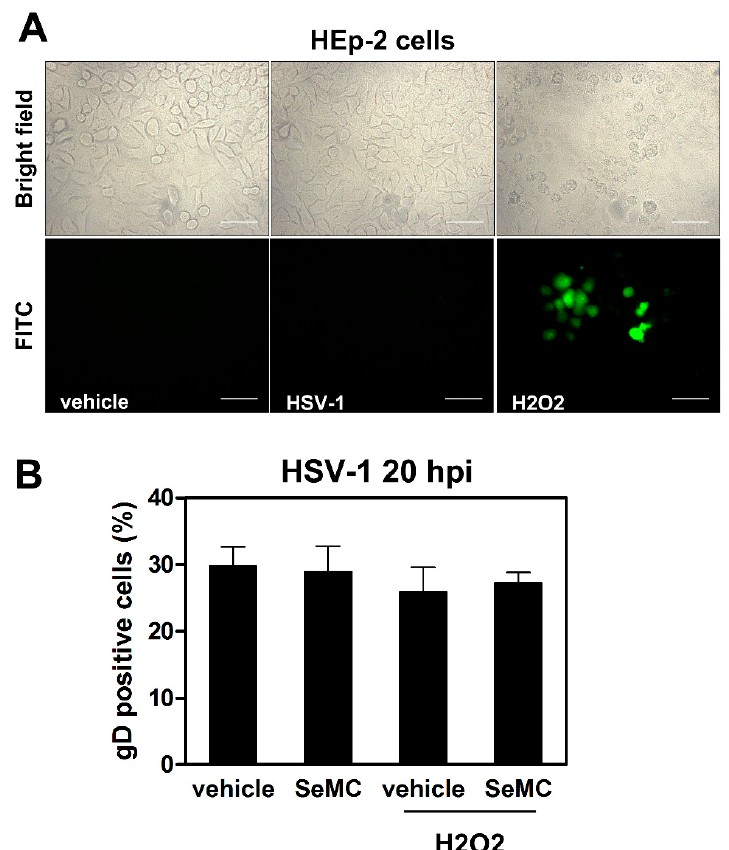
Figure 10. ROS modulation in HEp-2 cells infected by HSV-1. ( A ) Fluorescence microscopic analysis of cells preloaded with DCFH-DA before exposure to HSV-1 (MOI = 10 PFU / cell) for 2 h or treatment with 5 µ M of H 2 O 2 for 30 min. Objective: 40 × . Scale bar = 50 µ m. ( B ) Evaluation of gD-HSV-1 expressing cells by immunofluorescence microscopy analysis of cells cultured with vehicle or SeMC (20 µ M) for 48 h and then treated or not with H 2 O 2 (5 µ M) for 30 min before infection with HSV-1 (MOI = 0.5 PFU / cell). Cells were collected at 20 h post infection. Analysis by IFA is expressed as % positive cells (mean + S.D.) calculated from 10 di ff erent fields per conditions of two independent